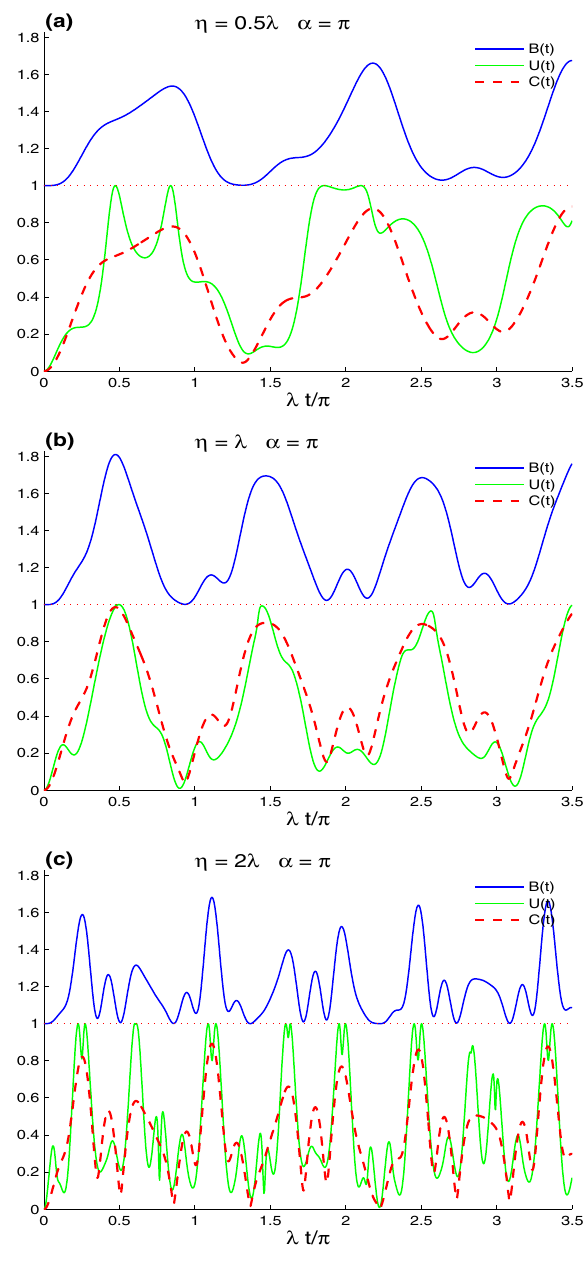
n y 1 , α π and when the lattice-point = = = 1 0 in the absence of the intrinsic decoherence with = | ↑ ��↓ | (cid:31) in ( b ), and η 0.5 (cid:31) in ( a ), η 2 (cid:31) in ( c = = =